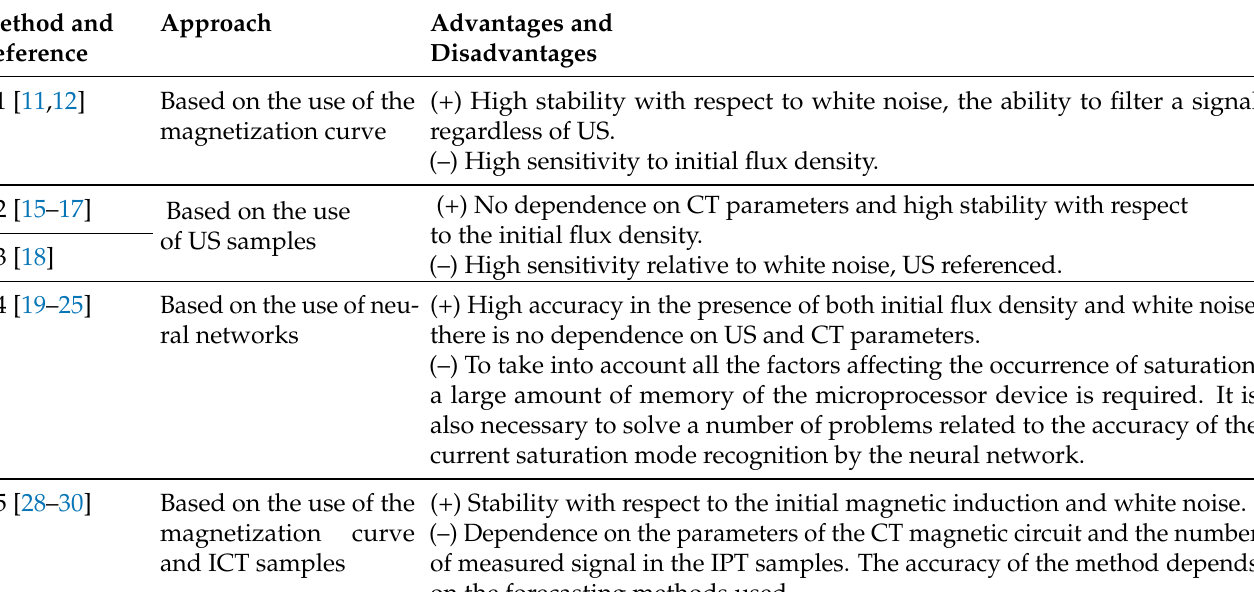
Table 3. Advantages and disadvantages of filtration